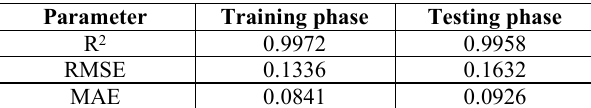
Table 1. Evaluation metrics for training and testing